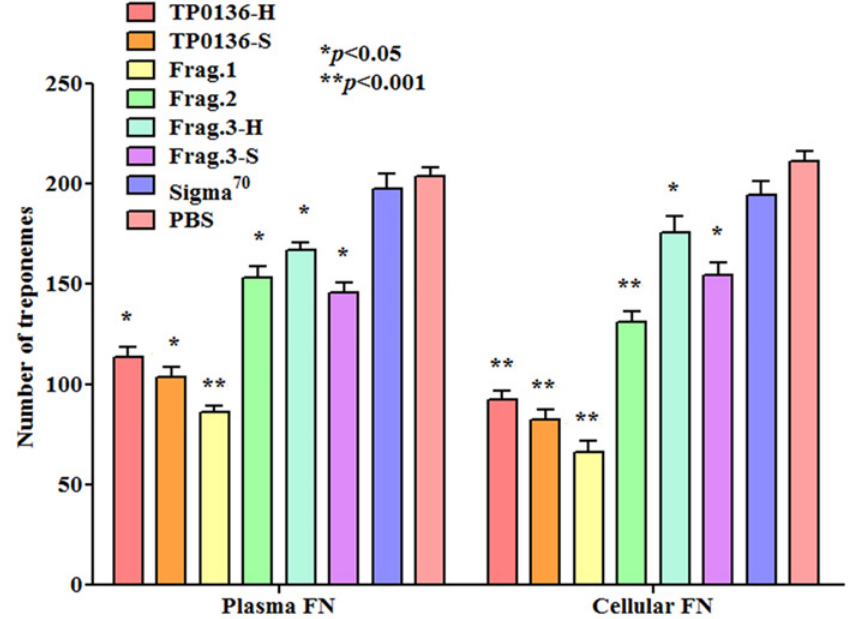
Fig 4. Inhibition of T. pallidum attachment to plasma and cellular fibronectin by recombinant TP0136 proteins. T. pallidum attachment to plasma and cellular fibronectin-coated slides is inhibited by slide pre- incubation with 800 pmol/well of recombinant proteins based on the TP0136 sequences form Nichols Houston and Nichols Seattle. T. pallidum σ 70 and PBS were used as negative controls. Experiments were repeated twice using each time triplicate wells per condition. Bars represent the mean number of T. pallidum cells counted in 10 fields of triplicate experiments ± standard error. Significance was assessed by comparing wells coated with recombinant proteins to the PBS control wells with Student ’ s unpaired two-tailed t-test and significance set at p (cid:2) 0.05. For comparison between different protein concentrations ANOVA test was used ( * p < 0.05; ** p <